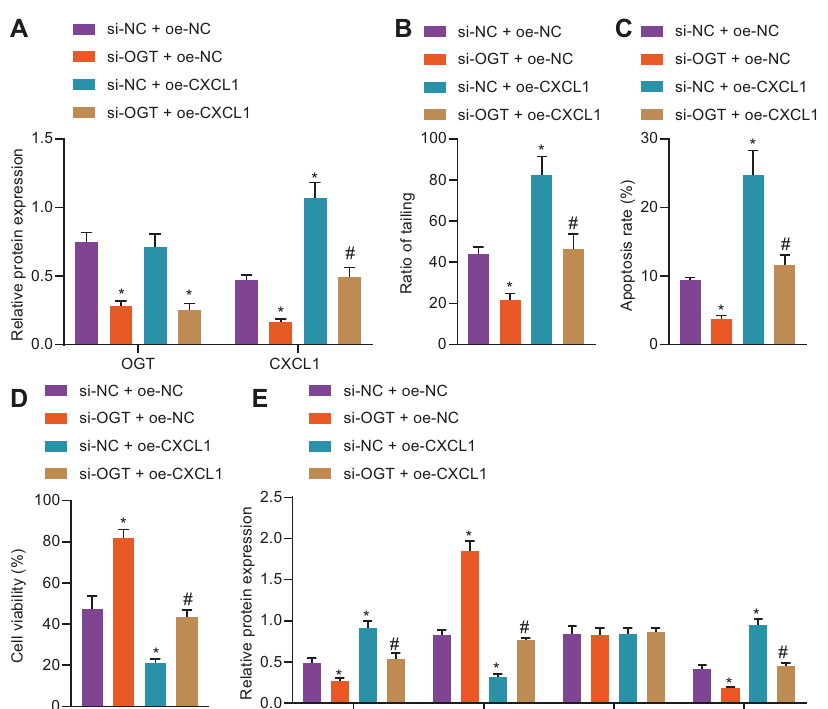
Fig. 5 Silencing OGT attenuates hypercalcemia-induced neurotoxicity by regulating the EZH2/KLF2/CXCL1 axis. A Western blot analysis was used to detect the expression of OGT and CXCL1. B Comet assay was used to observe DNA damage. C Flow cytometry was used to detect apoptosis. D MTS assay was used to detect neuronal viability. E Western blot analysis was used to detect the expression of apoptosis-related proteins. * p < 0.05. vs. the si-NC + oe-NC group (neurons treated with si-NC + oe-NC). # p < 0.05. vs. the si-OGT + oe-NC group (neurons treated with si-OGT + oe-NC). The experiment was repeated 3 times